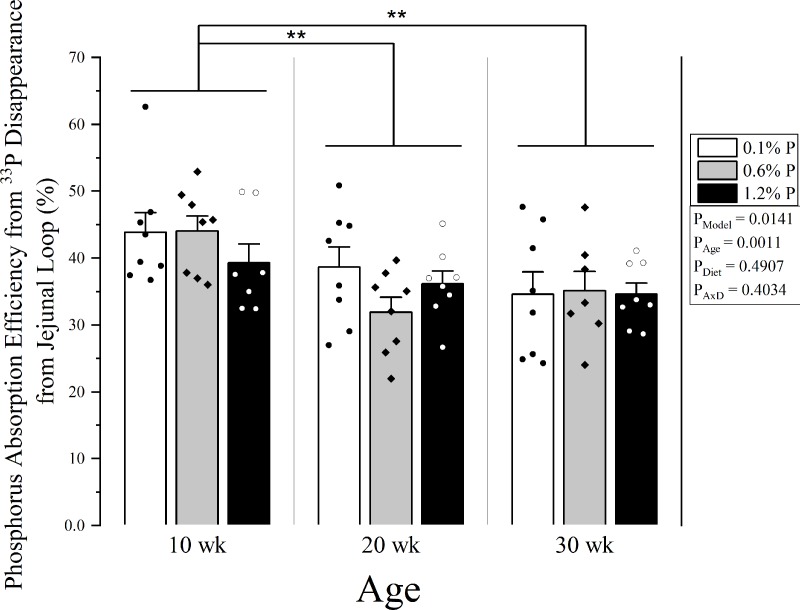
Percent jejunal phosphorus absorption efficiency by age and dietary phosphorus intake level.Phosphorus absorption efficiency was calculated as 1-(33P activity remaining in jejunal loop)/(Total 33P activity in dose) after 30 minutes post 33P injection into the jejunal loop. Means and standard error bars are shown for each group. Low phosphorus diet (0.1%) is shown in white bars and black dots; normal phosphorus diet (0.6%) is shown in grey with black diamonds; and high phosphorus diet (1.2%) is shown in black with white circles. ANOVA p-values for the overall model (PModel), main effect of age (PAge), main effect of diet (PDiet), and interaction of age and diet (PAxD) are shown. There was a main effect for age where 10 week old rats had higher phosphorus absorption compared to both 20 and 30 week olds, but there was no significant effect of dietary phosphorus intake level and no significant age x diet interaction. ** p < 0.01. n = 2 excluded, 1 for mishandling loop, and 1 unphysiologic (counts ~150 fold lower than expected).